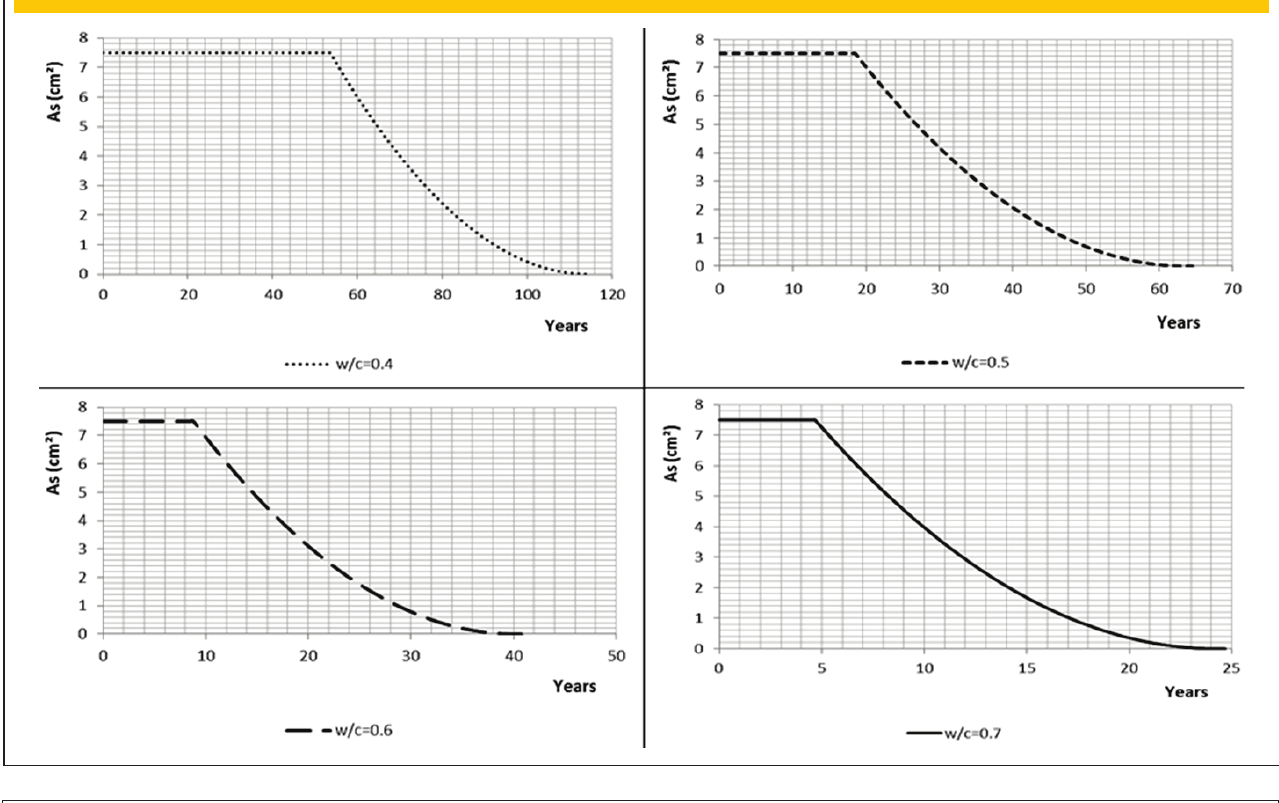
Figure 12 – Initiation and propagation periods considering CA III and β x=0.259